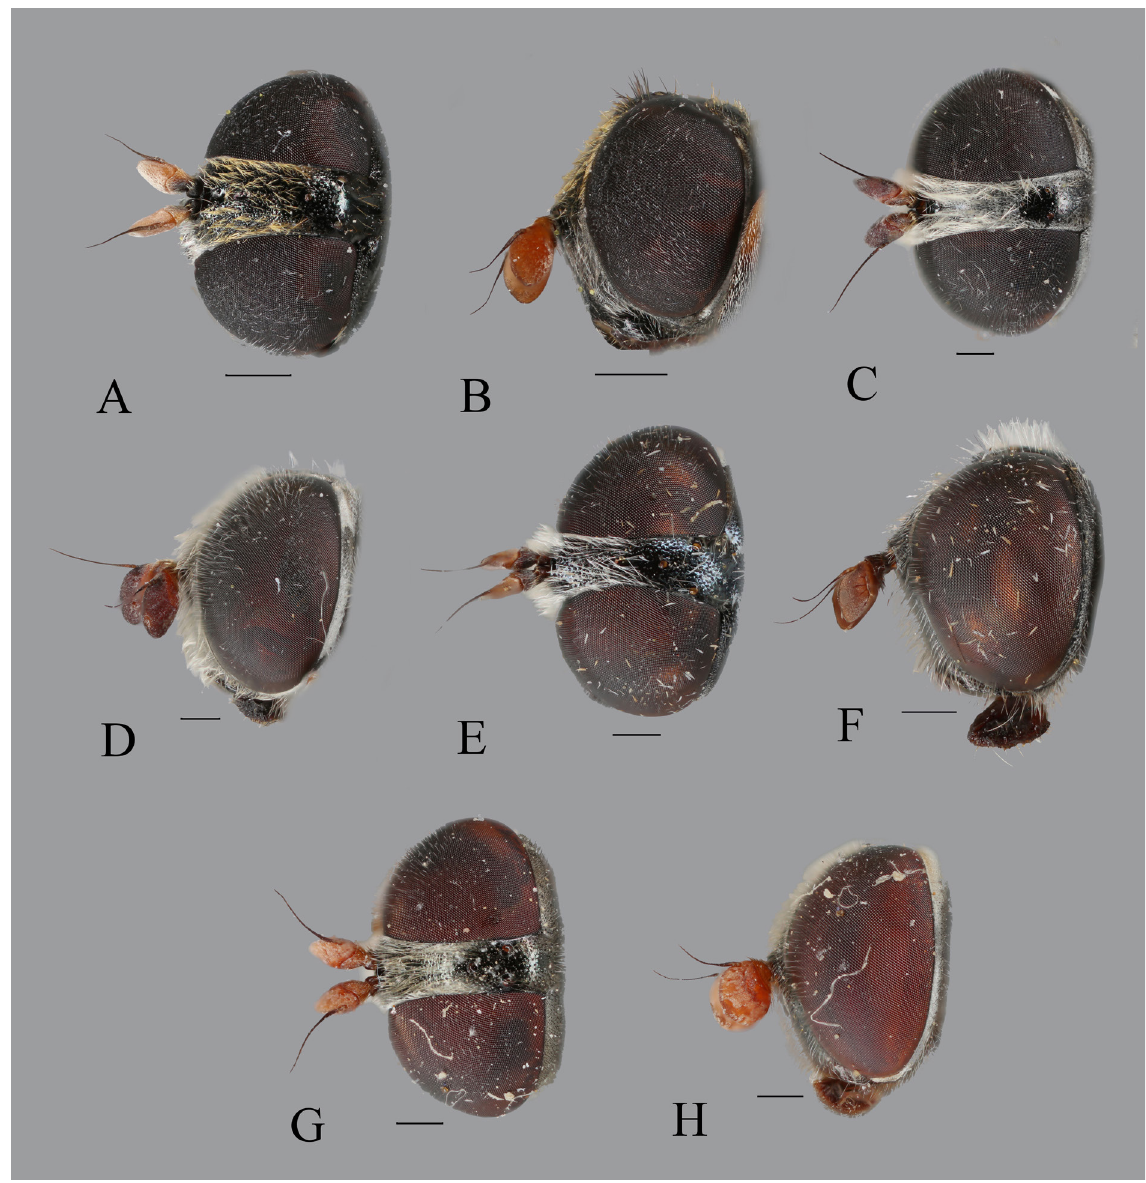
Fig. 14. Head, ♀, dorsal view (A, C, E, G) and lateral view (B, D, F, H). A–B . Eumerus brevipilosus Gilasian & van Steenis sp. nov., paratype (HMIM). C–D . E. coeruleus (Becker, 1913), Ghoochan, Iran (HMIM). E–F . E. longitarsis Peck, 1979, Mian Jangal, Iran (JSA). G–H . E. persarum Stackelberg, 1961, Bazman, Iran (JSA). Scale bars = 0.5